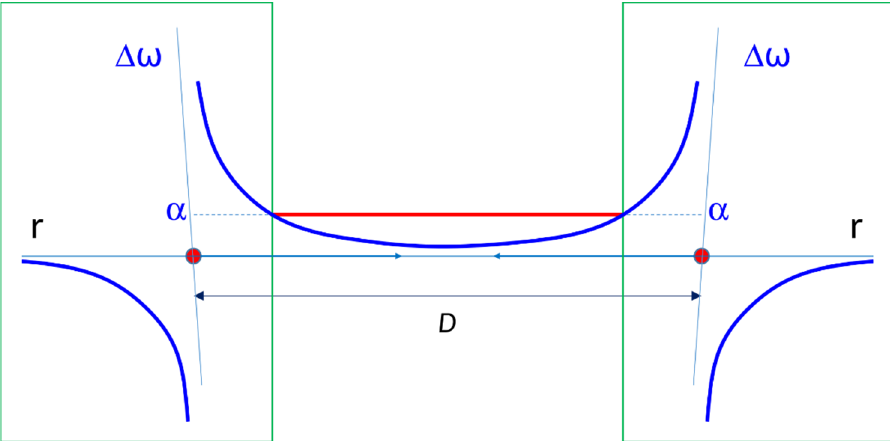
Figure 6. Schematic representation of the distortion of the Bragg reflecting planes associated with two parallel dislocations with opposite Burgers vectors and distant from D . A zone in between the two dislocations retains a misorientation α instead of going down to zero (red straight line instead of continuation of the decreasing curve). The energy of the dislocations is associated with the zones indicated by the green rectangles and reduces to k · t · E d instead of 2 · t · E d , with k <